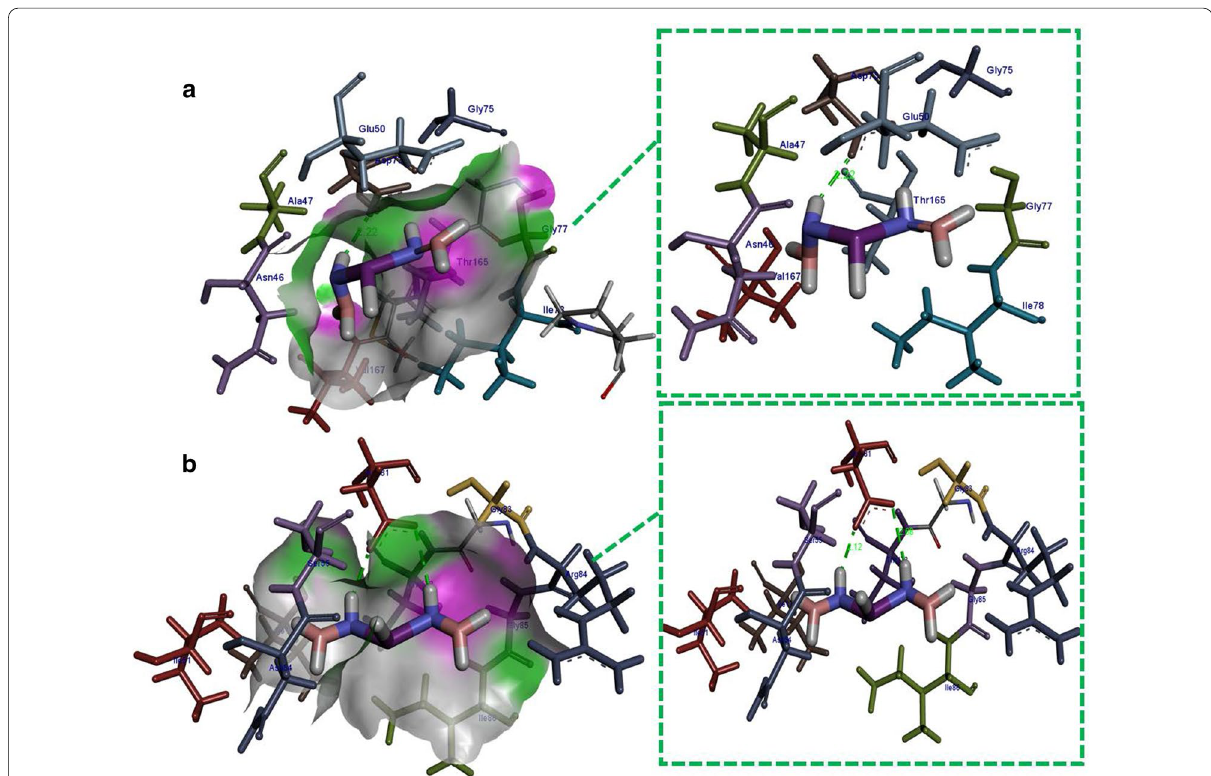
Fig. 11 Binding interaction pattern of Bi‑doped BN nanosheets with active site residues of DNA gyrase from ( a) E. coli and (b) S.